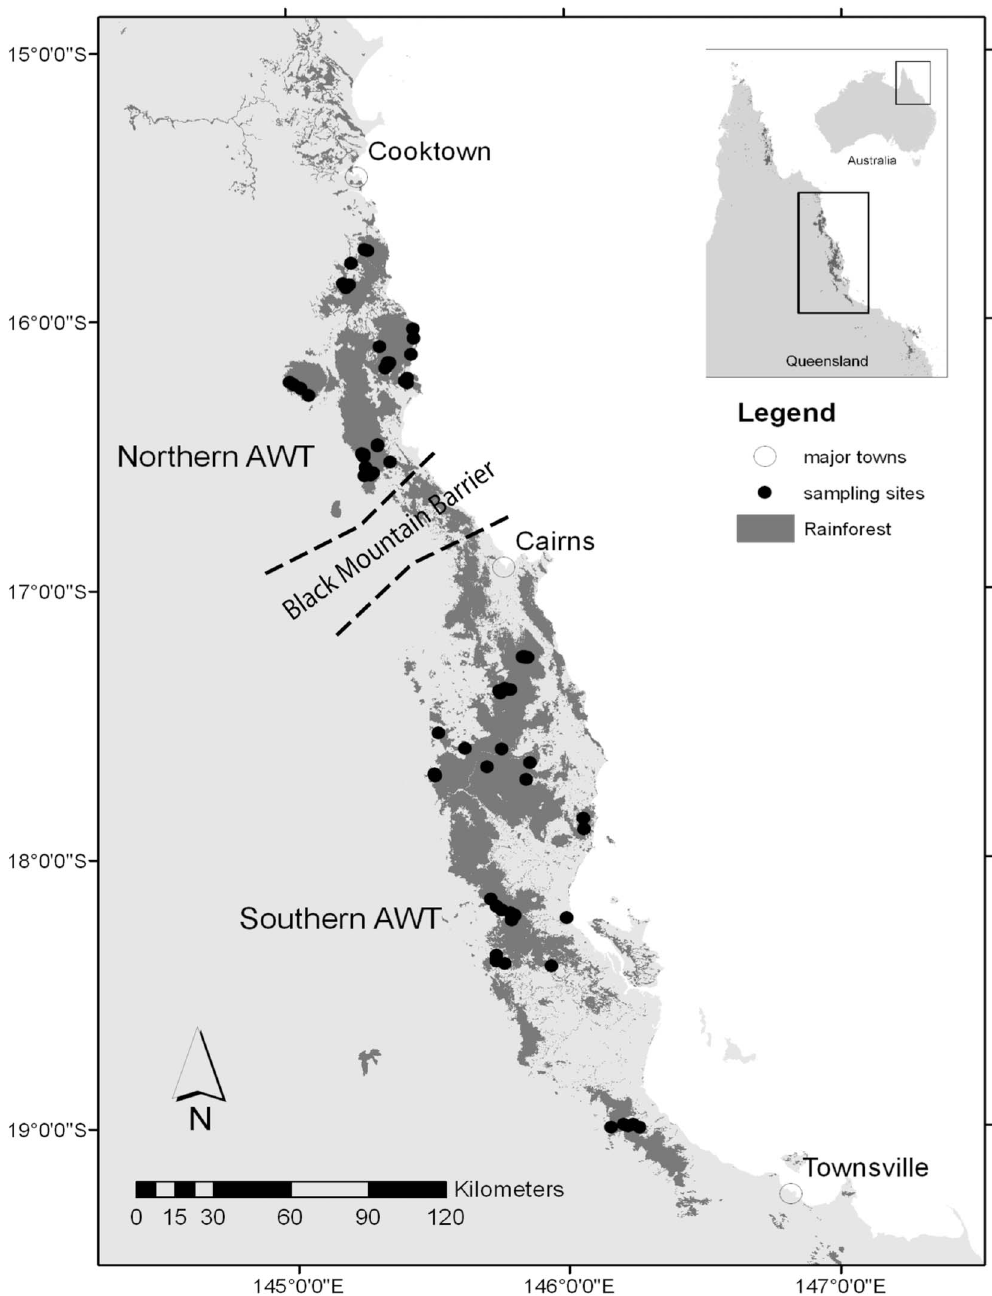
Figure 1. Rainforests sampling areas within the study region. Areas dominated by rainforest vegetation are shaded in dark grey. Dotted lines indicate a major biogeographic barrier (the Black Mountain barrier, see text) separating the northern and southern AWT regions compared in this study.